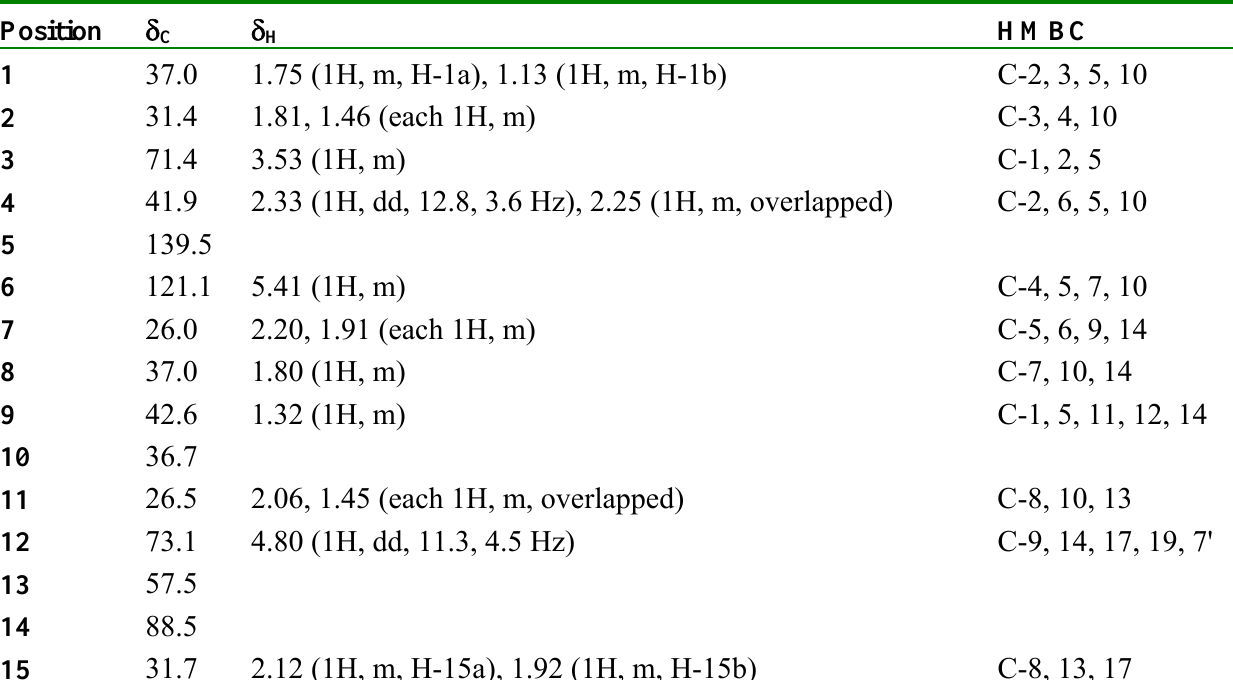
Table 1 . The NMR data of compound